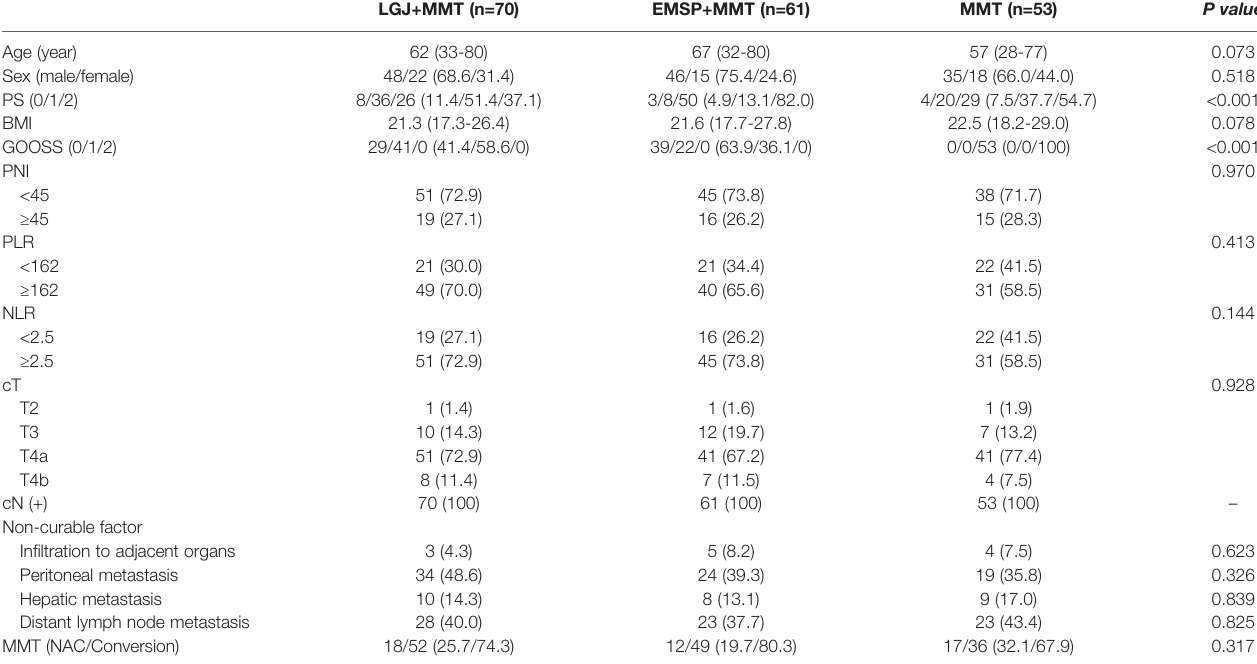
TABLE 1 | Baseline Patients